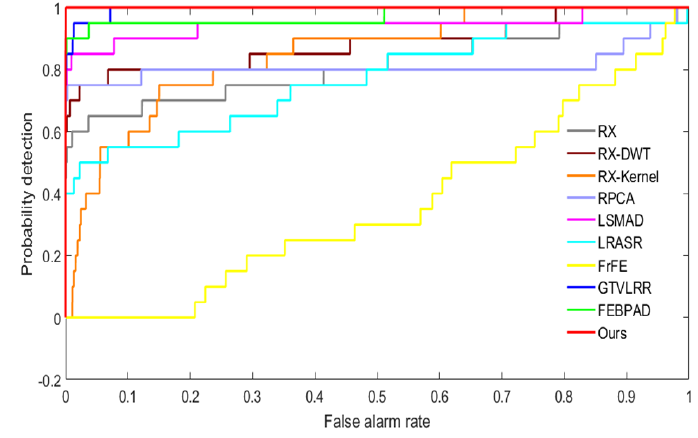
Figure 14. ROC curves of anomaly detectors on the simulated dataset.